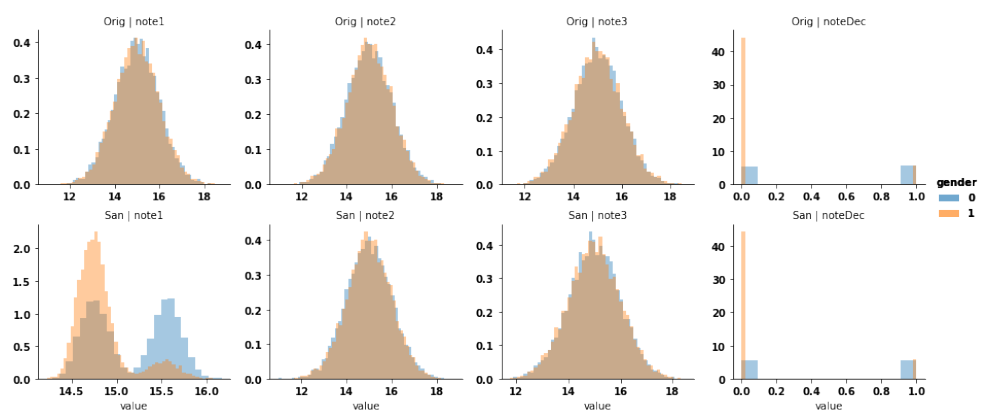
Figure 14. Distribution of all attributes in the datasets. Top: Original data distribution, Bottom: Sanitized distributions. From left to right, attributes: note 1 , 2, 3 and the decision. The original data shows the similarity between distributions, but different decisions. The sanitizer aligned the distribution of note 1 such that it match the decision criteria, the sensitive attribute has not been hidden yet.